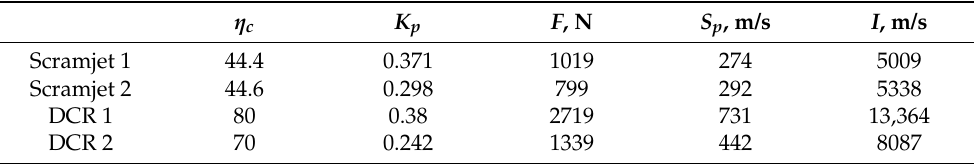
Table 3. Overall engine performance for DCR and